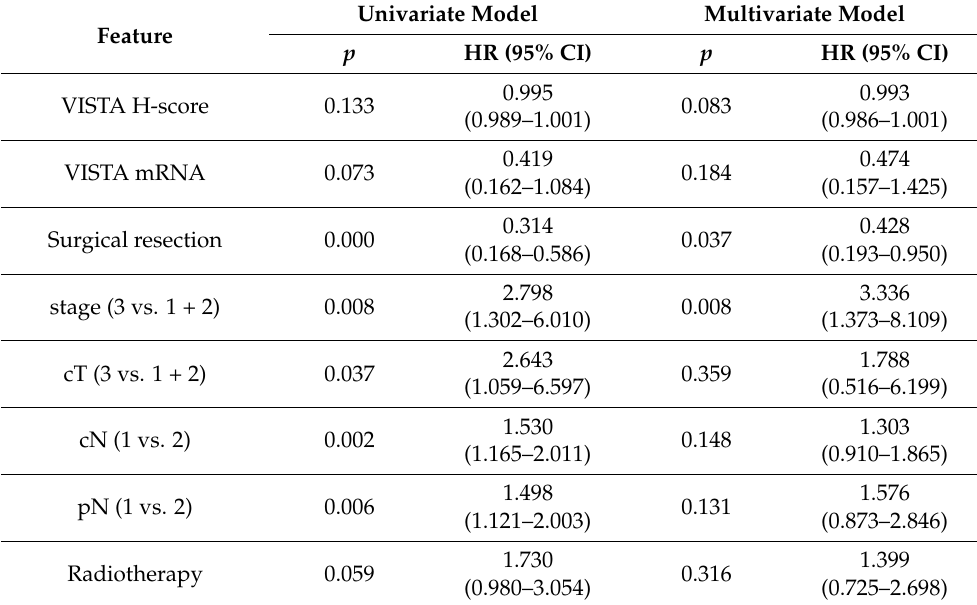
Table 3. Univariate and multivariate Cox regression models. VISTA H-score, mRNA, and significant predictors of OS were